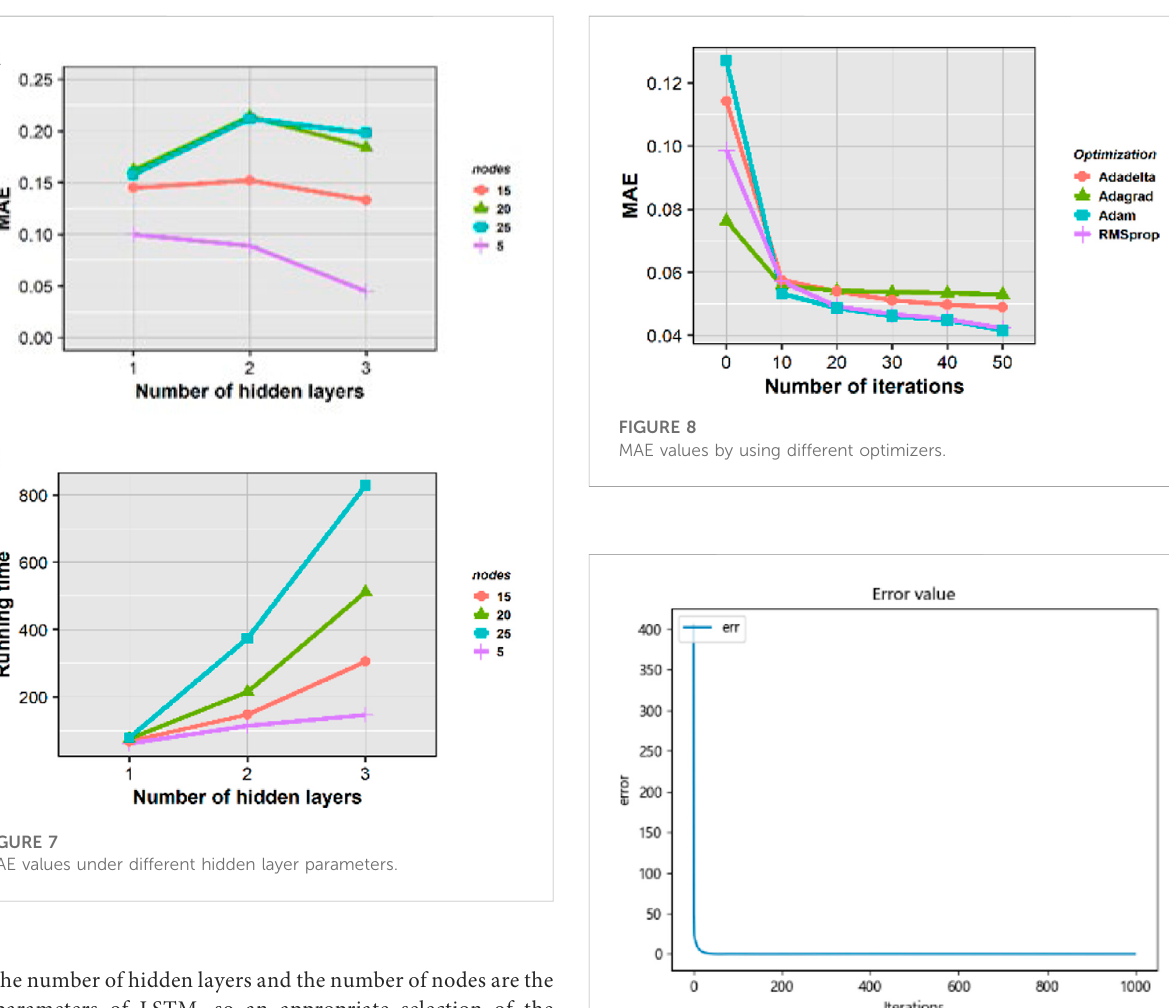
FIGURE 9 Error function